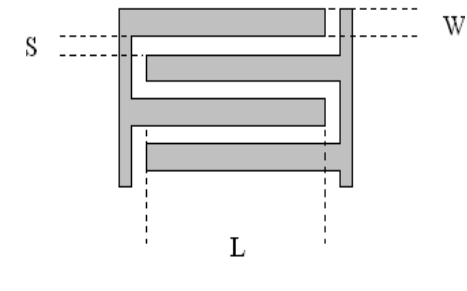
Fig. 2: Interdigitated sensor structure of 4 electrodes. The dimensional parameters L, W, and S are finger length, finger width and finger spacing,